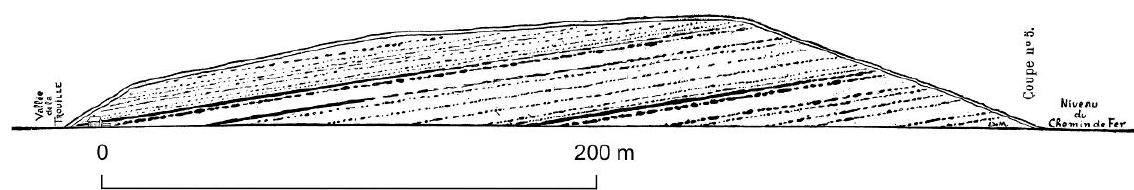
Figure 6. Spiennes. Cross section drawn along the railway embankment showing the high number of flint seams in Camp-à-Cayaux (de Loë & de Munck 1891).